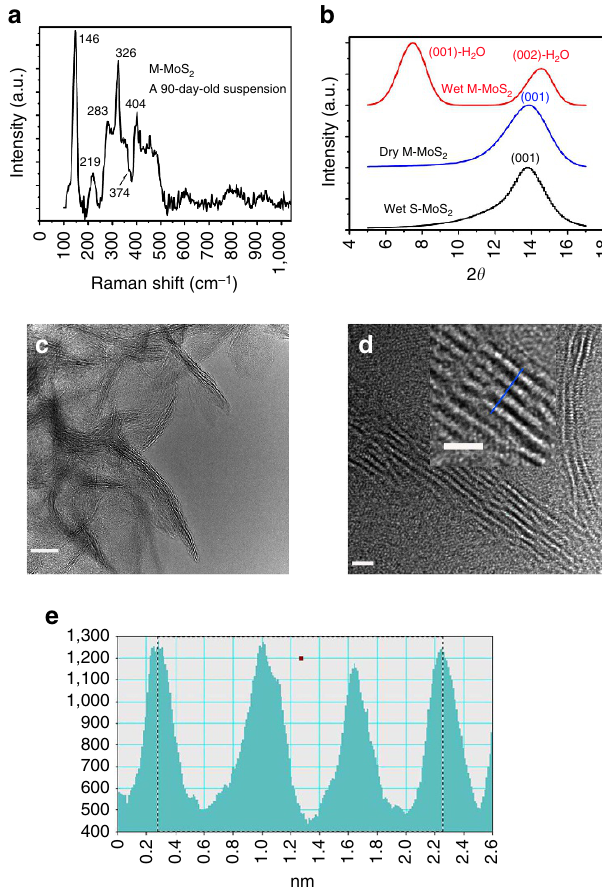
Figure 3 | Raman and structural characterization to investigate the stability of M-MoS 2 . ( a ) Raman shift of M-MoS 2 stored for 90 days at room temperature. ( b ) XRD patterns of wet M-MoS 2 , dry M-MoS 2 and wet S-MoS 2 . ( c ) Low-resolution TEM image of M-MoS 2 . Scale bar, 10nm. ( d ) HRTEM image of M-MoS 2 . The region indicated by the square is enlarged to show the layered structure of M-MoS 2 . Scale bar, 2nm. ( e ) Line scan of the HRTEM image indicated by the blue line in d , indicating a layer-to-layer spacing of